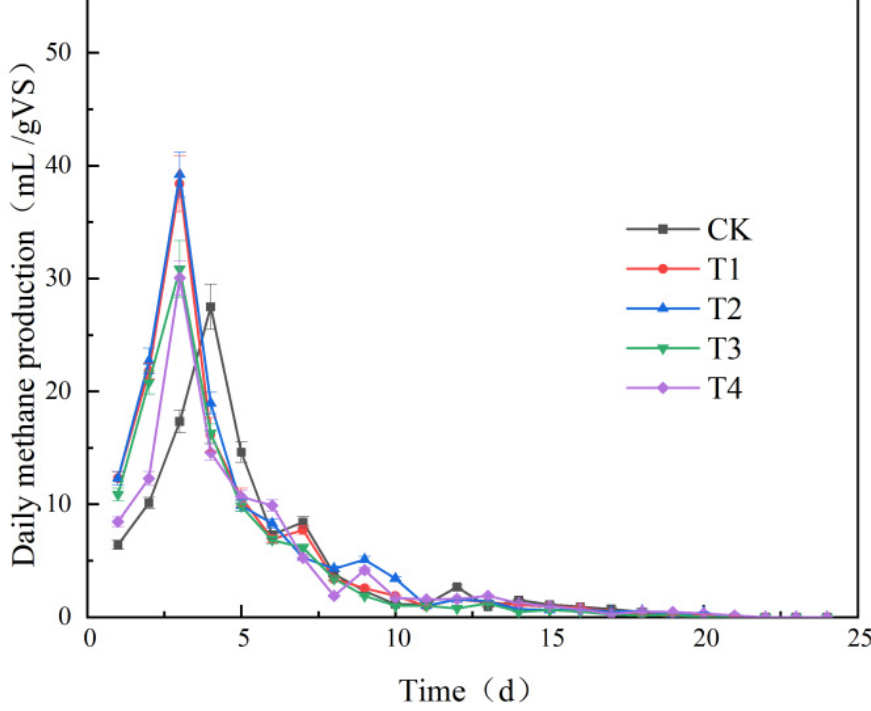
Figure 9. Effect of biogas slurry reflux on methane production during anaerobic digestion.